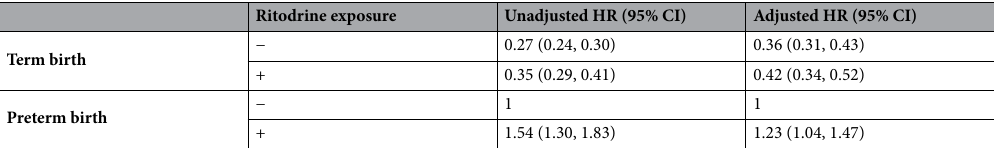
Table 3. Hazard ratios (HRs) of autism in term and preterm birth; subgroup analysis of autism with respect to preterm birth without ritodrine group. Hazard ratios were adjusted for maternal age, parity, cesarean section, preterm labor, steroid use, low birthweight, large for gestational age, male gender, and preeclampsia.